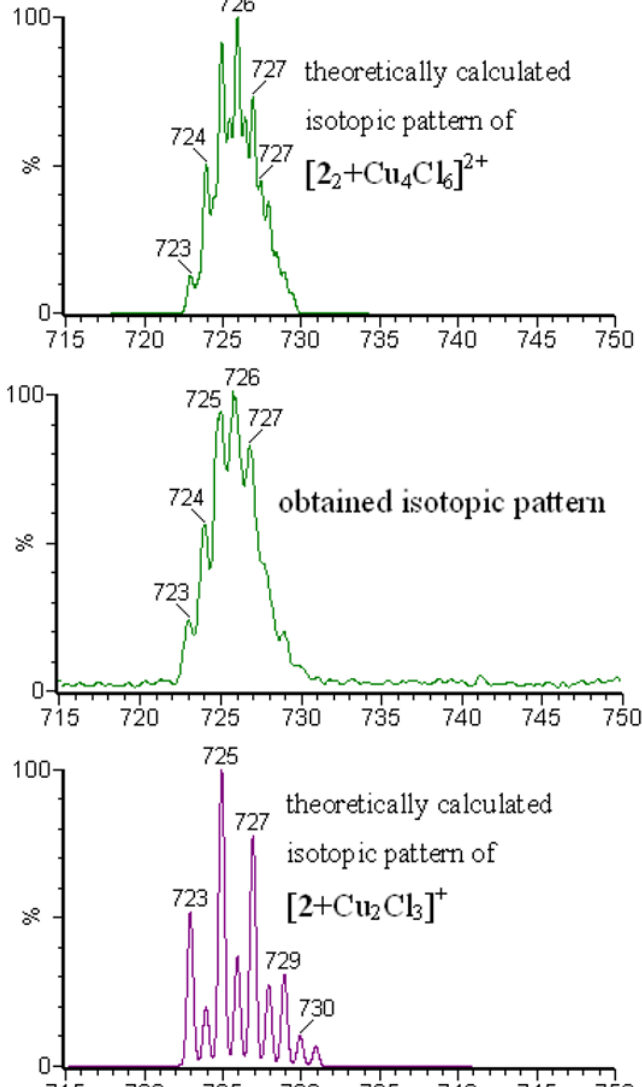
Figure 5. Comparison of the obtained isotopic pattern with theoretically calculated isotopic patterns of [2